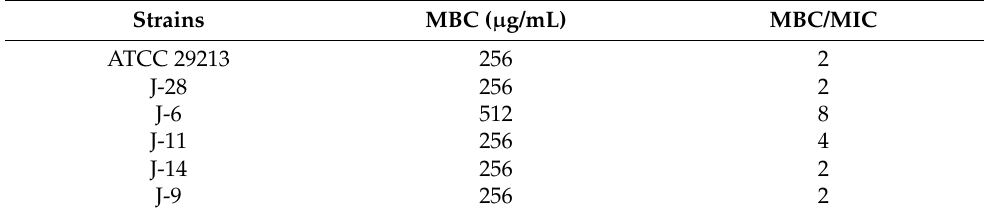
Table 2. Minimum bactericidal concentrations and the ratio of minimum bactericidal concentration to minimum inhibitory concentration of piceatannol against different Staphylococcus aureus strains. Strains MBC ( µ g/mL) MBC/MIC ATCC 29213